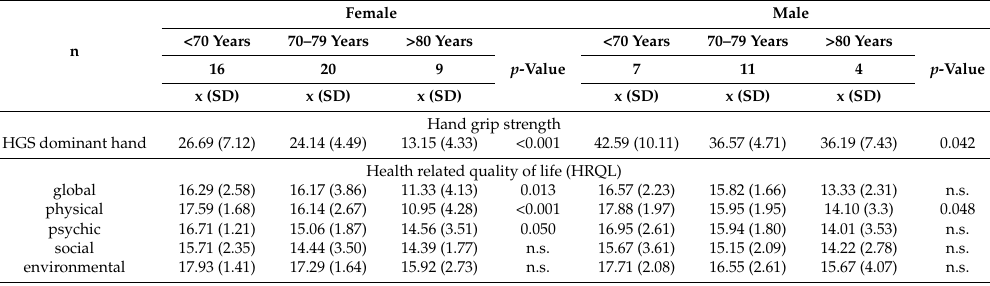
Table 2. Hand grip strength and health-related quality of life (domains) according to sex and age (Kruskall-Wallis